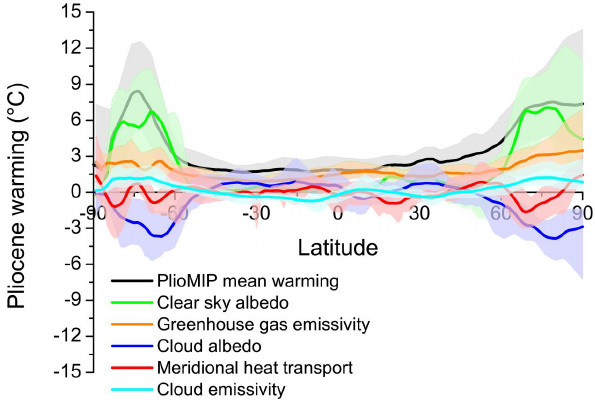
Fig. 4. Summary of the PlioMIP Experiment 2 energy balance anal- ysis. Solid line shows the multi-model mean warming for each com- ponent, with the associated shading representing the range. These values have been interpolated onto a 1 ◦ latitude grid for compari- son